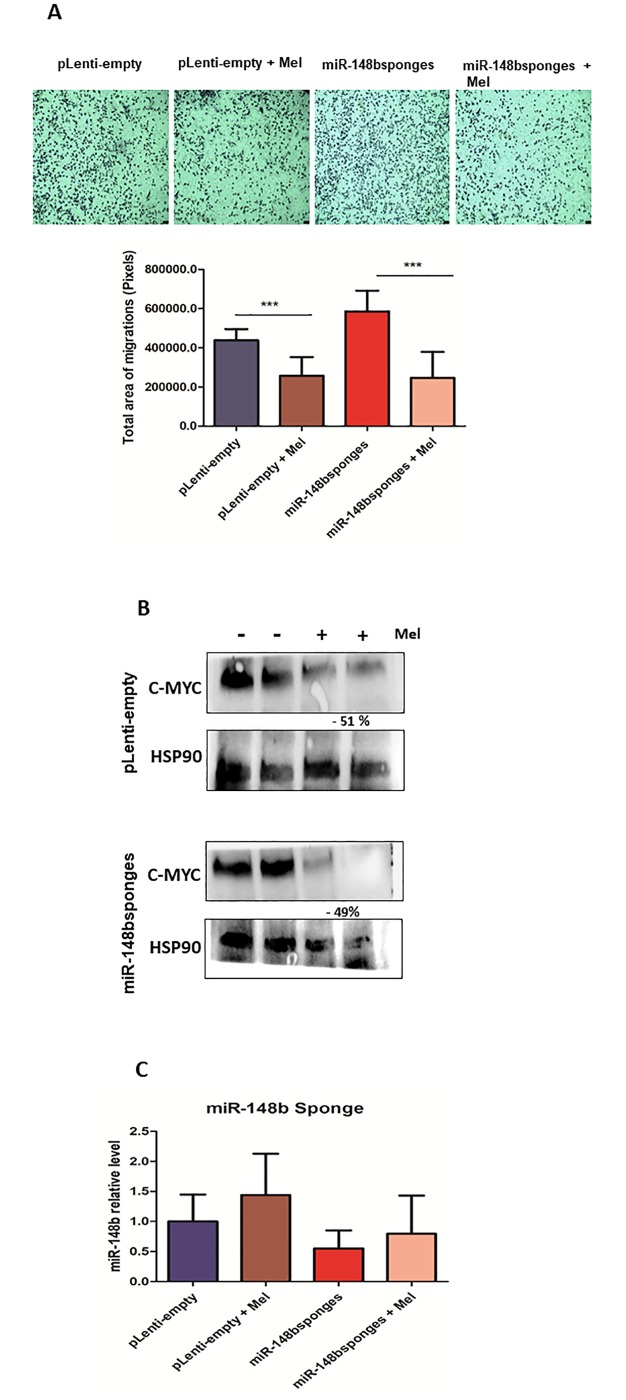
Melatonin reduces migration and c-Myc expression independently of miR-148b (A) 4175-TGL cells transduced with miR-148bsponges or pLenti-empty lentivirus have been treated with melatonin (1 mM) for 48 h and subjected to transwell migration assays. Histograms represent cell migration rate. Data represents the mean ± SEM of the transwell area covered by migrated cells, performed in triplicates plus or minus melatonin (p*** < 0.0001 treatment versus control). (B) 4175-TGL cells transduced as described above were treated with melatonin for 48 h and protein extracts were subjected to Western Blotting with the indicated antibodies. Protein expression was quantified by ImageJ program and calculated relative to controls, normalized with the endogenous HSP90 and expressed as percentages (%). (C). 4175-TGL cells transduced as described above were treated for 48 h and miRNA levels measured by qRT–PCR analyses. Results are shown as fold changes (mean±s.e.m.) relative to control cells, normalized on U6 level. (p > 0.05 treatment versus control). SEM = Standard Error of Mean.